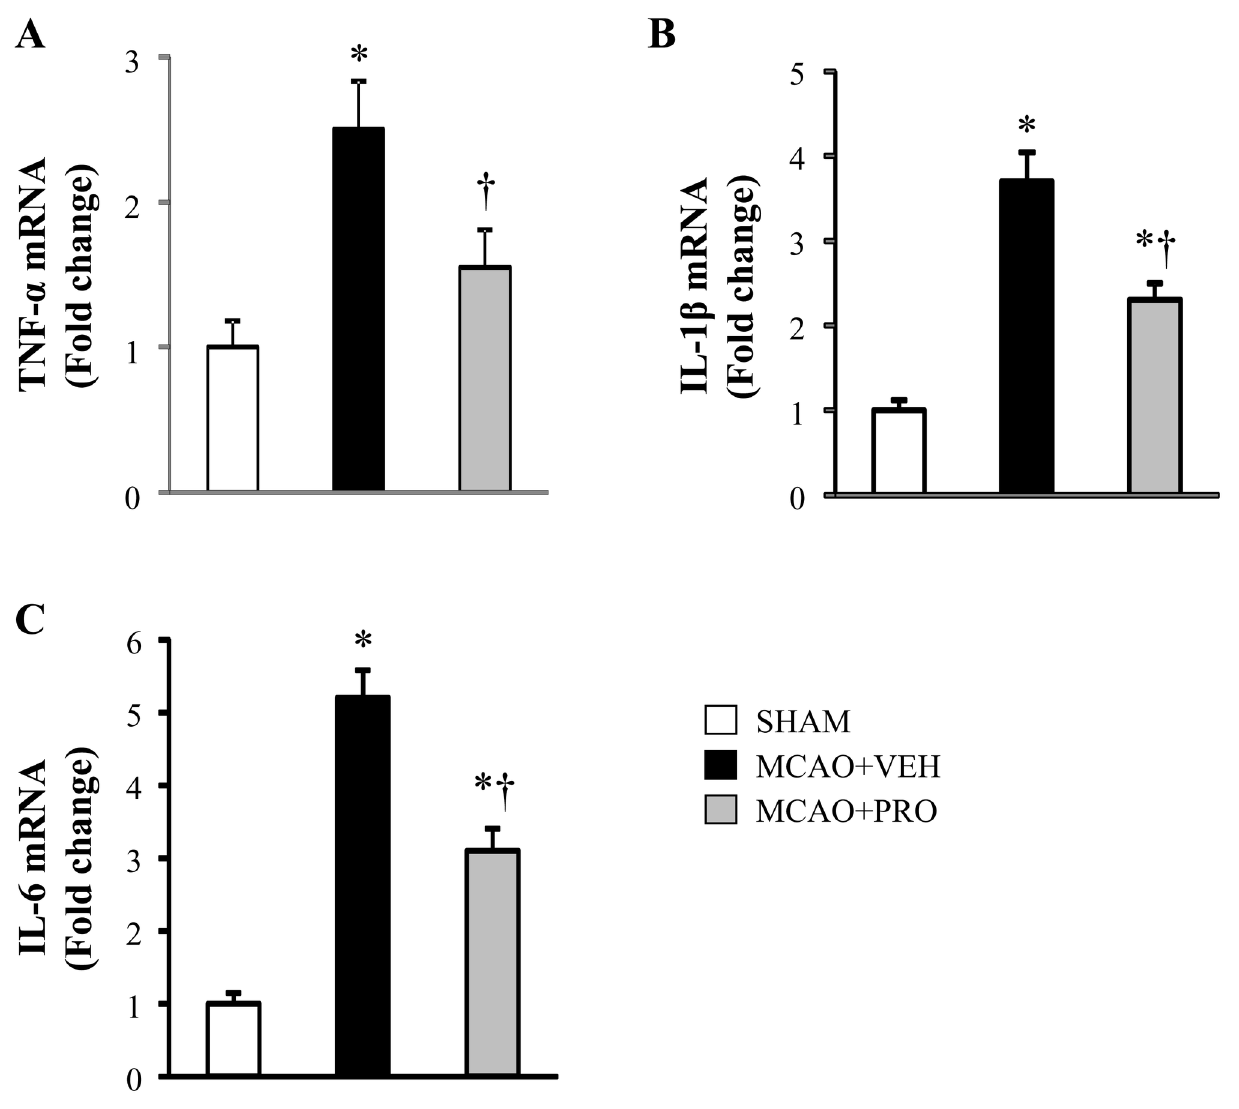
Figure 4. mRNA expression for proinflammatory cytokines TNF-α (A), IL-1β (B) and IL-6 (C) in the peri-infarct cortical tissue 24 h after MCAO in rats treated with VEH or PRO. SHAM rats without treatment were used as control. Values are mean ± SEM (n = 8 for each group) and expressed as a fold change relative to SHAM. * P < 0.05 vs. SHAM, † P < 0.05 MCAO+PRO vs.